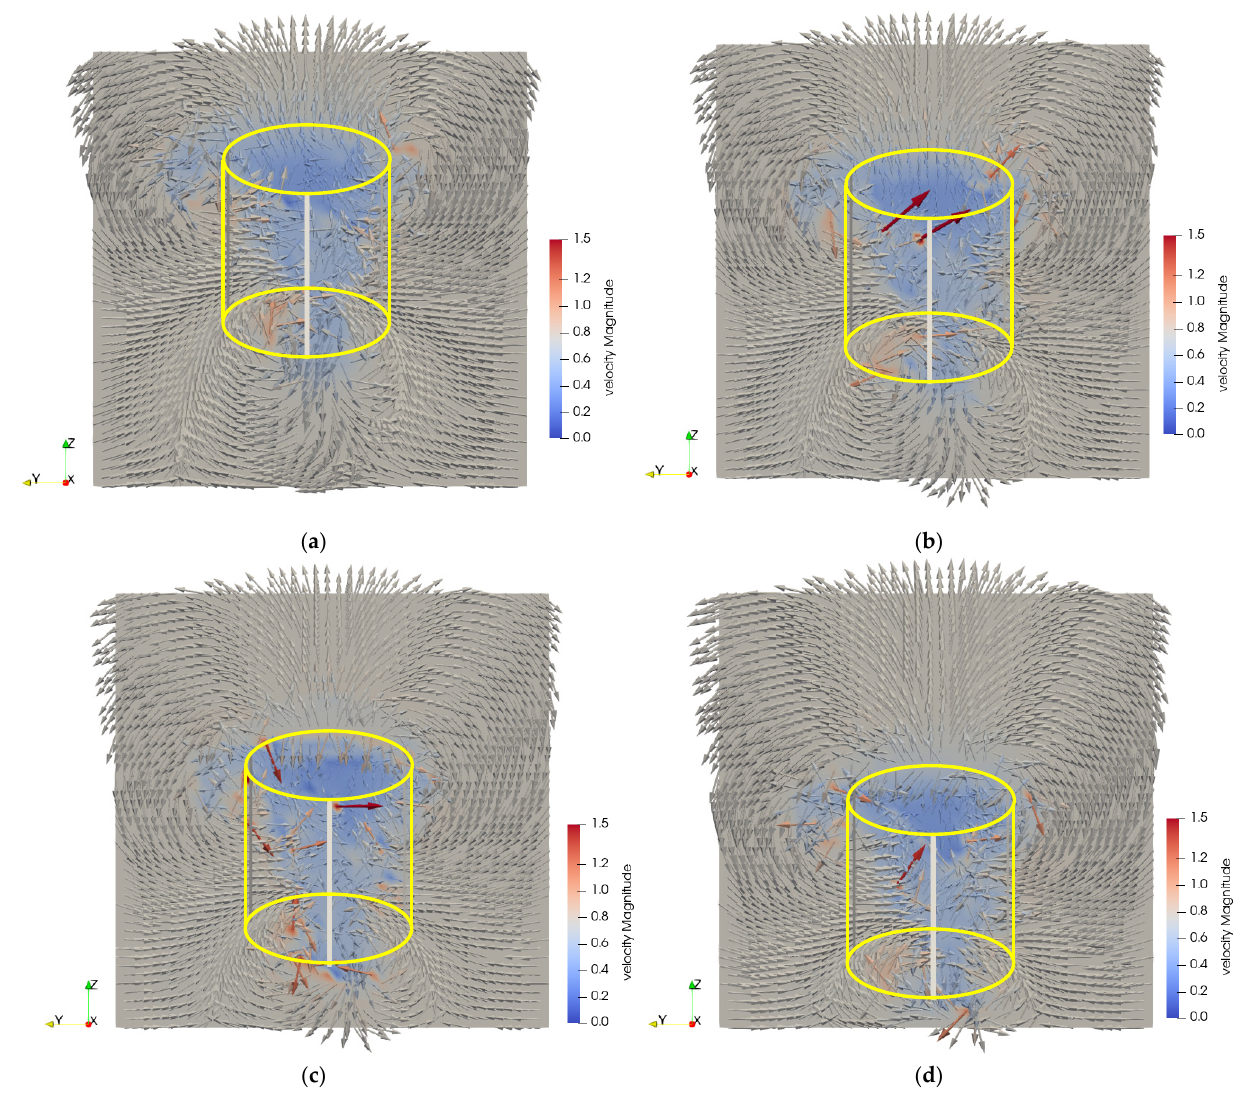
Figure 12. Wind velocity vector in the YZ-plane behind a 20-degree-tilted VAWT with different ground clearance: ( a ) 1.0D; ( b ) 0.8D; ( c ) 0.6D; ( d ) 0.4D.